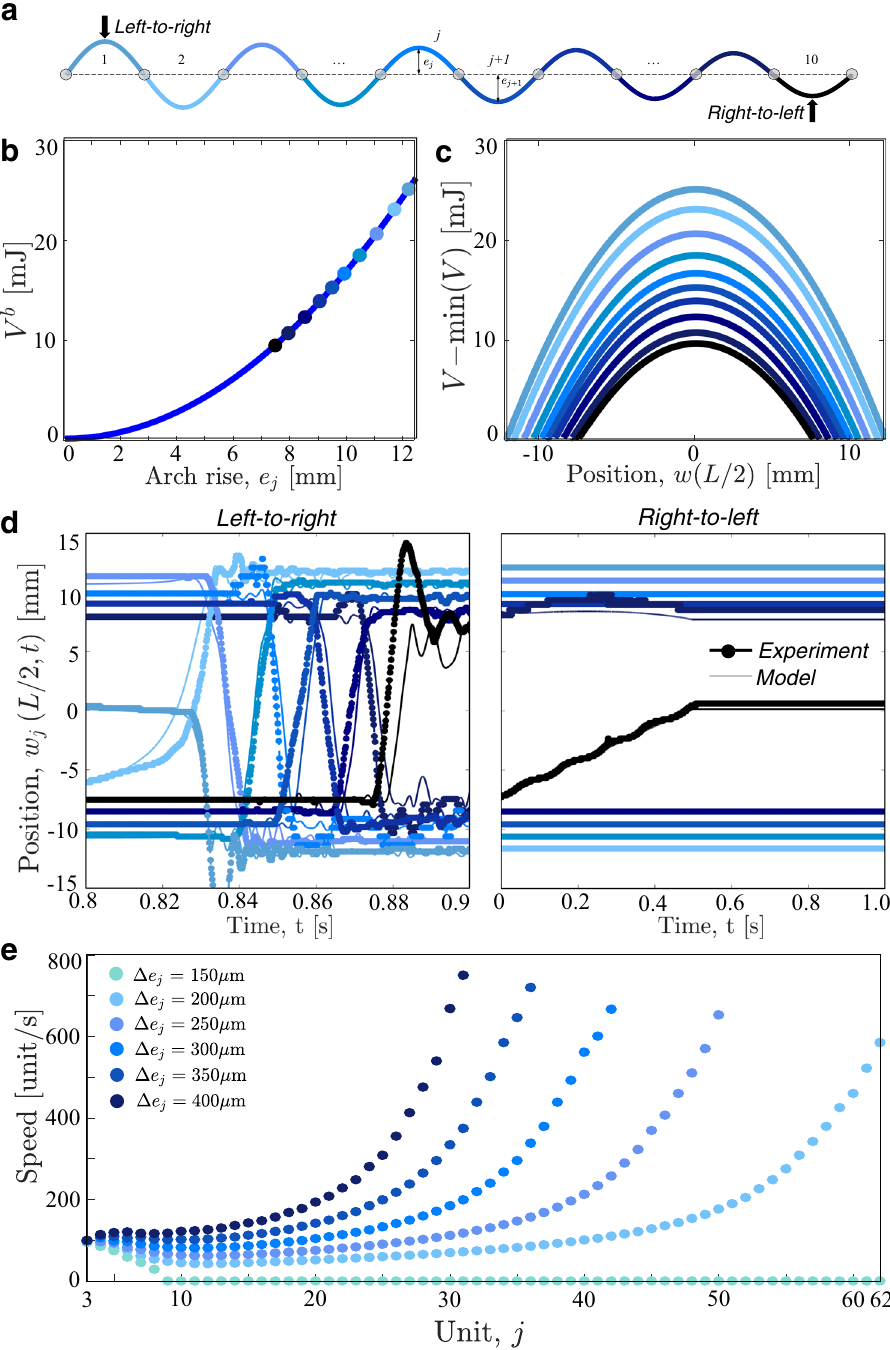
Fig. 3 Symmetric elements — graded and asymmetric array. a Schematic of the system with N = 10 arches with decreasing rises. b Energy barrier, V b , versus arch rise, e j . c Normalized on-site energy potential, V (cid:1) min ð V Þ , versus the position of the arch midpoint. d Evolution of the positions of the midpoints of the arches, w j ( L /2, t ), for tests in which the indenter acts on the leftmost (left-to-right) and rightmost (right-to-left) arches (see Supplementary Fig. 19 for corresponding numerical contour maps). Thick-dotted and thin lines correspond to experimental and numerical results, respectively. e Local speed of the transition wave along the chain for different values of Δ e j as predicted by our